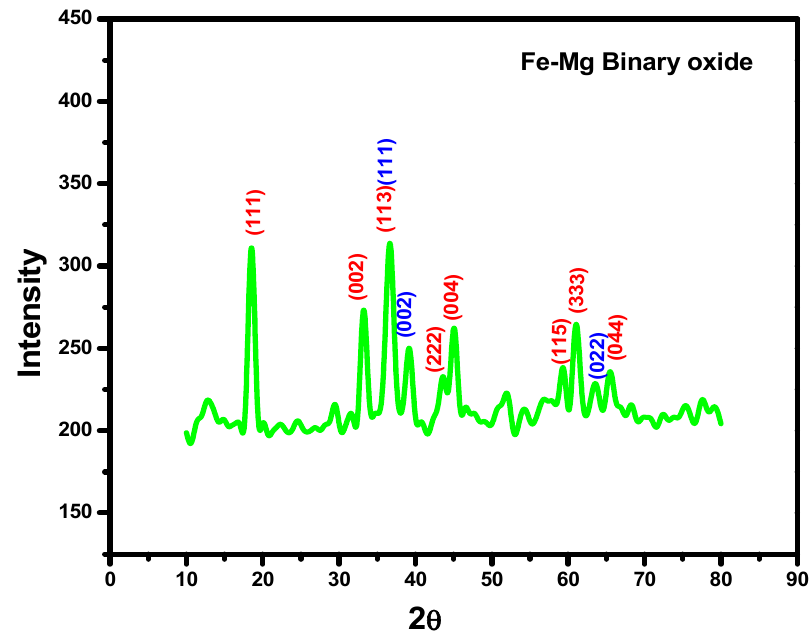
Figure 1. X-ray diffraction (XRD) pattern of Fe-Mg binary oxide nanoparticles. The average crystallite size of the synthesized sample is calculated by using Debyee Scherrer’s formula given in Equation (1) [35,36].